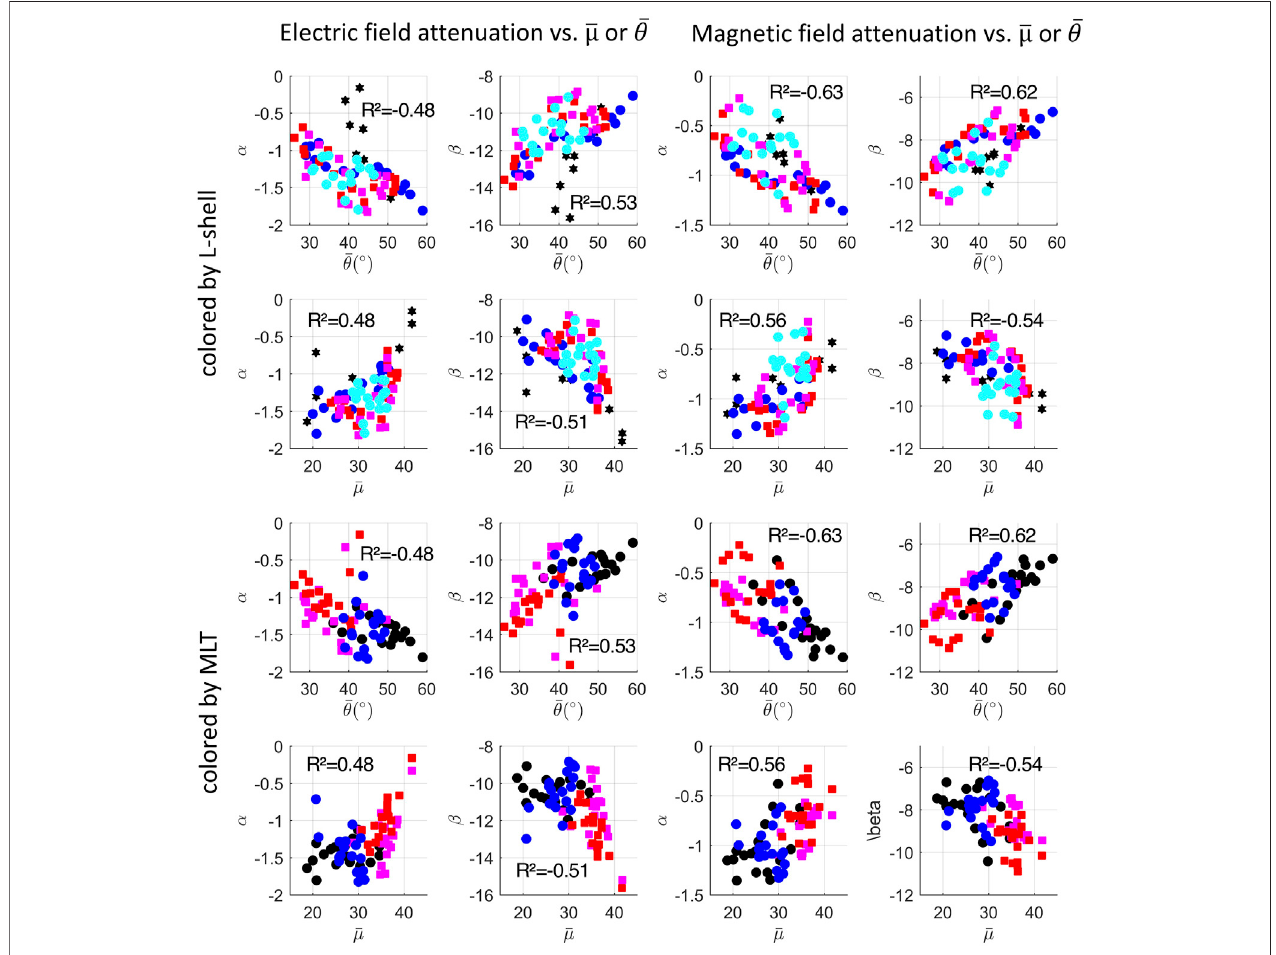
FIGURE12| (fourleftoftwo fi rstrows)Electricand(fourrightoftwo fi rstrows)magnetic α - β -parametersoftheattenuationlawsplottedwithrespectto( fi rstrow)the wave normal angle and (second row) the refractive index colored by (2 fi rst row) MLT. (2 last rows) Figures of the two fi rst rows are repeated but colored by L-shell. Pearson correlation coef fi cient R 2 is given for each fi gure. Colored codes are given in Figure 10 with dark colors for night sectors and small L-shells.